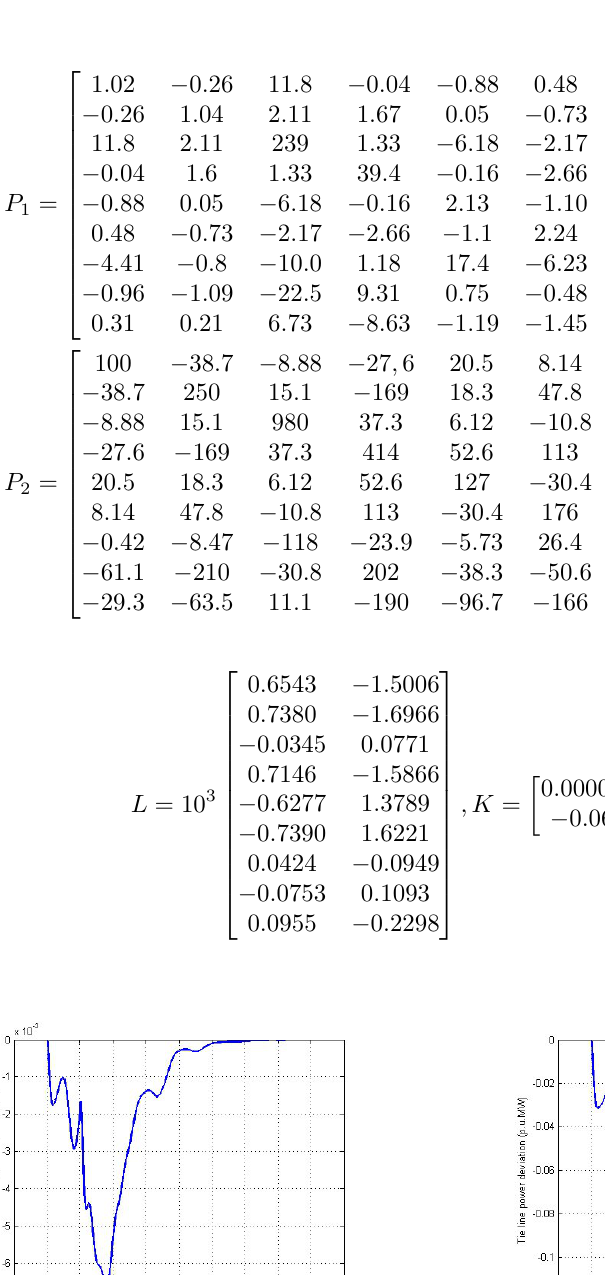
augmented power